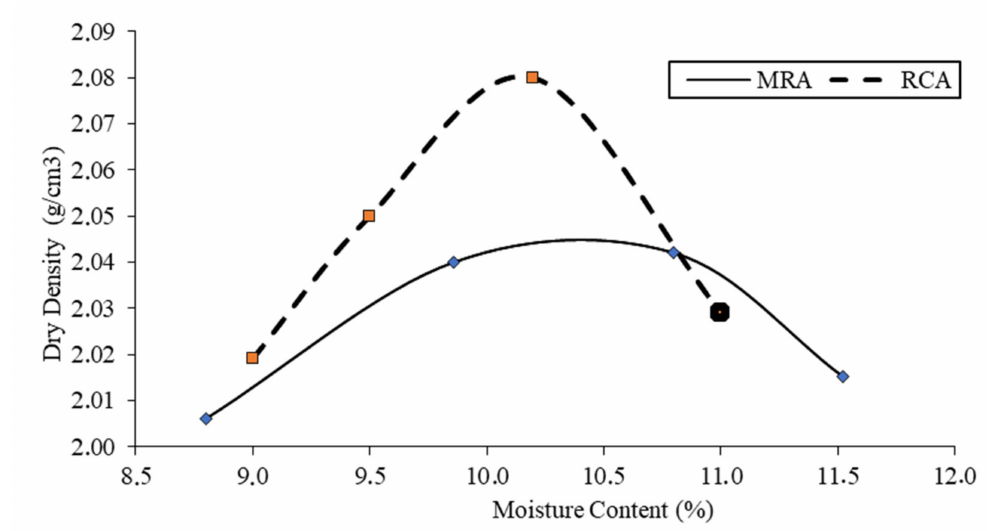
Figure 4. Moisture—dry density ratio.